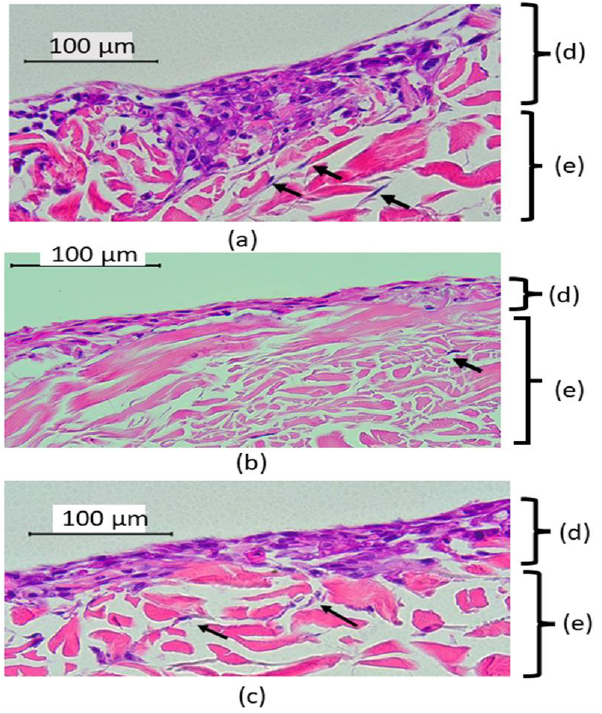
Figure 3. Histological appearance of 3D-OMMs, unexposed ( a ), after 72 h exposed to 3-YZP ( b ) IC ( c ). Black arrows indicate that the HGFs migrated into connective tissue and were occasionally present inside the stroma ( e ). The epithelial layers ( d ) were inconsistent. (Original magnification, 40 ×